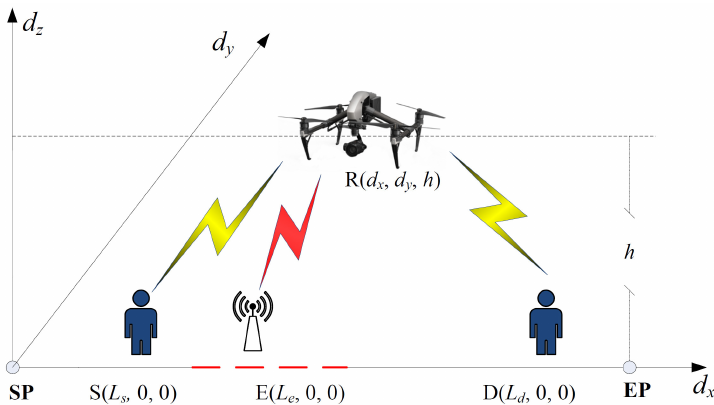
Figure 1. The UAV-enabled mobile relaying system